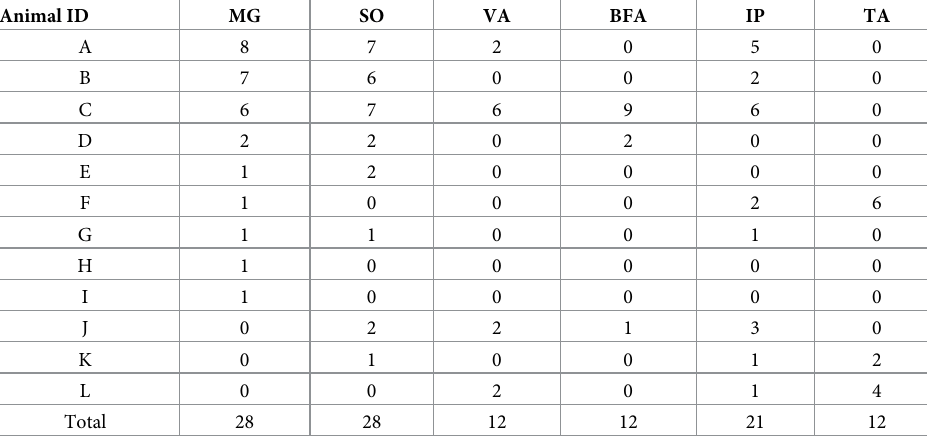
band pass filtered (30–1000 Hz) and amplified. Since our CPG model describes the operation of a HCO that acts as a rhythm generator and generates excitatory inputs to the neural network that activates flexor and extensor motoneurons, we analyzed paw-shake EMG recordings from hindlimb muscles with flexor and extensor locomotor activity (25). These muscles included flexors tibialis anterior (TA, ankle flexor) and iliopsoas (IP, hip flexor) and extensors soleus (SO, ankle extensor), medial gastrocnemius (MG, ankle extensor and knee flexor), vastus later- alis and vastus medialis (VA, knee extensor), and anterior biceps femoris (BFA, hip extensor). For each of these muscles, we measured the progression of EMG burst characteristics of paw-shake cycles throughout each paw-shake episode. In order to measure these burst charac- teristics, we first full-wave rectified the EMG signal and slightly smoothed it using a zero-lag, moving average with an 8-ms window. For each channel, we then took a random time interval with no muscle activity that was at least 200 ms wide and determined the mean and standard deviation of the raw EMG signal within this selection. The standard deviation was used as a measure of the EMG noise level in each trial. We set the activity burst threshold to be 3 times this standard deviation. We defined the EMG paw-shake cycle period (CP) for each muscle as the time between the EMG burst onset in a given cycle and the burst onset in the next cycle. The EMG burst duration BD was defined as the time between the burst onset and offset, and EMG interburst interval IBI was defined as the time between the burst offset and next burst onset. The duty cycle DC was calculated as 100 � BD/CP. We analyzed changes in BD and IBI in all consecutive cycles of individual paw-shake epi- sodes for each muscle: 28 episodes for MG, 28 for SO, 12 for VA, 12 for BFA, 21 for IP, and 12 for TA (Table 3). Each paw-shake episode had between 5 and 11 cycles. We calculated Pear- son’s correlation coefficient for BD and IBI versus time for each paw-shake response within each muscle group. The median Pearson’s correlation coefficient (R) of all trials within each muscle group was greater than 0.7 for IBI of MG, SO, VA, and BFA; and for BD of IP, TA, and VA. For the IBI of IP and TA and for BD of MG, SO and BFA, BD/IBI appeared to remain constant over time, and therefore, R varied widely from trial to trial with a median R anywhere